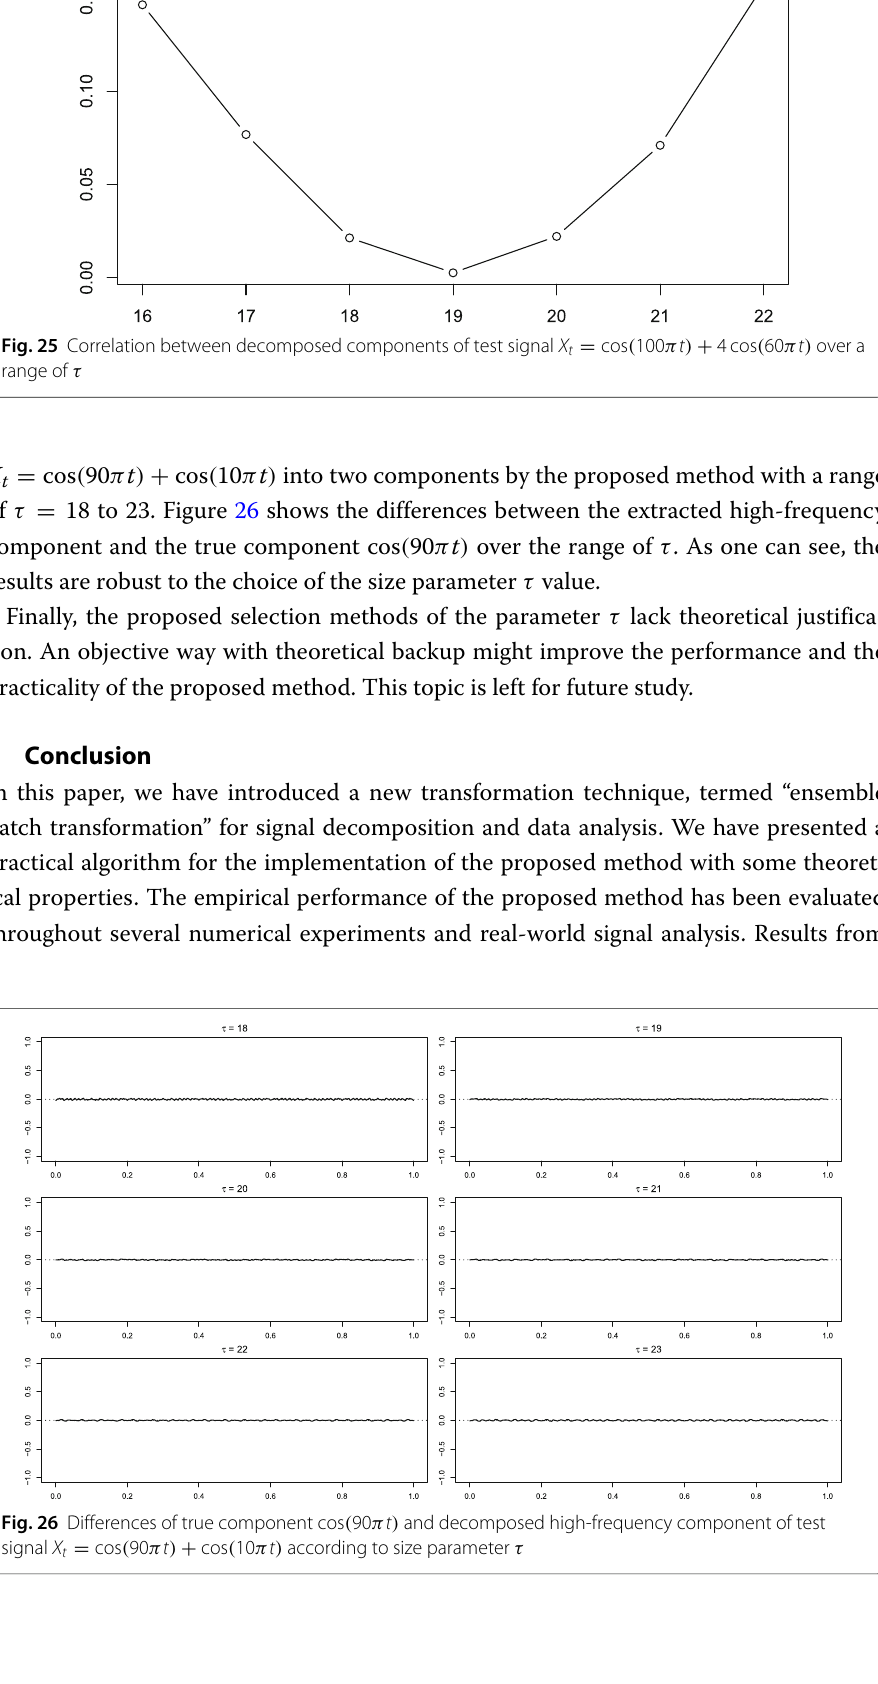
Fig. 25 Correlation between decomposed components of test signal X t = cos ( 100 π t ) + 4cos ( 60 π t ) over a range of τ